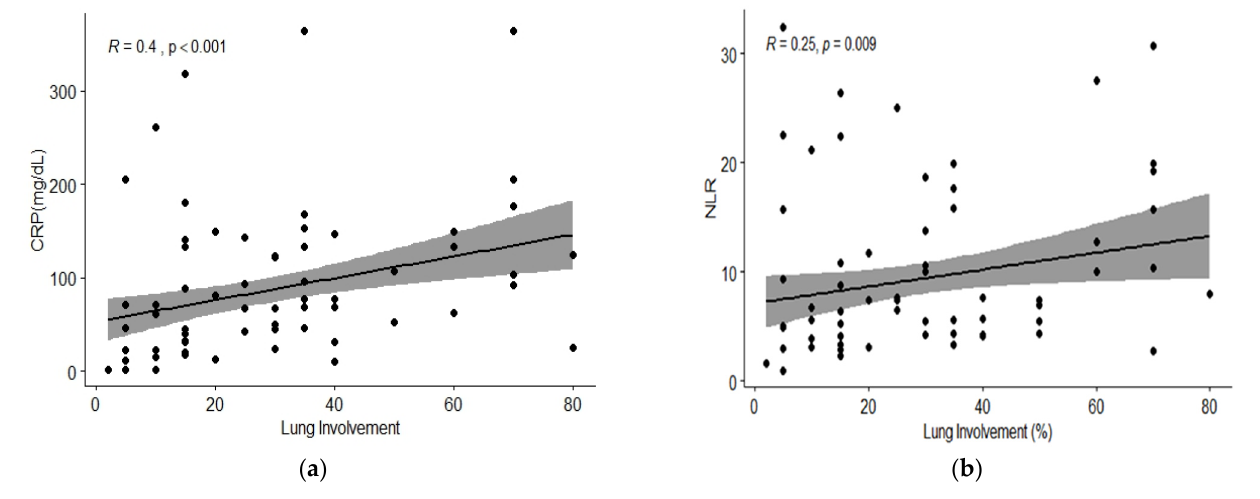
Figure 1. Correlation of chest CT lung involvement with different inflammatory biomarkers: ( a ) C-reactive protein (mg/dL); ( b ) neutrophil to lymphocyte ratio. On the x-axis, the lung damage in percent (continuous scale) is represented and on the y-axis the value of CRP and NLR respectively.